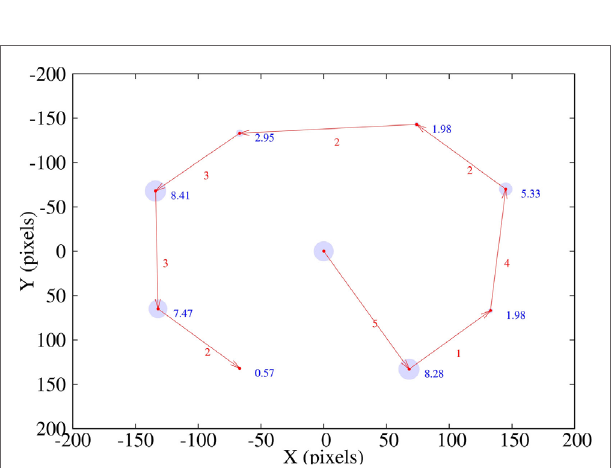
FigUre 11 | execution performance, including coarse and fine motions: initial stimulus locations in the picture through 84 test patterns (blue squares), ending stimulus locations during the approaching saccadic movement (red crosses), mean error (red circle), and final stimulus locations during the tuning saccadic movement (green crosses)